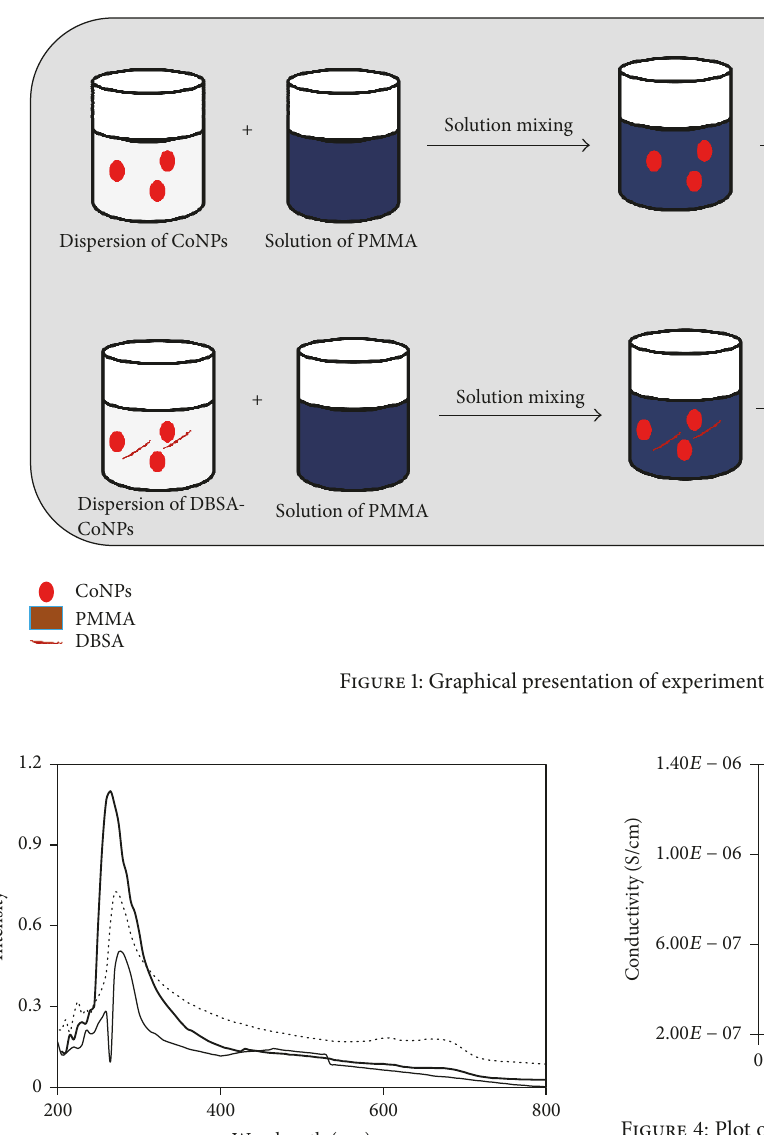
Figure 4: Plot of conductance of DBSA-CoNPs/PMMA (thin line) and CoNPs/PMMA (thick line) as a function of contents of